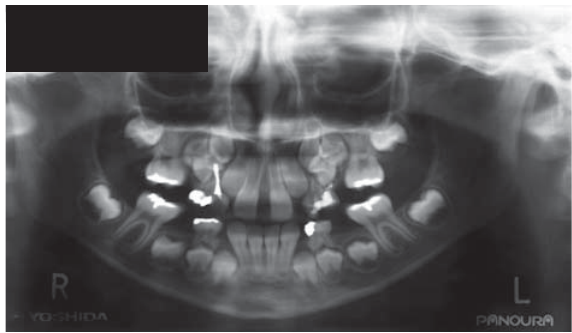
Figure 3- Initial panoramic radiograph